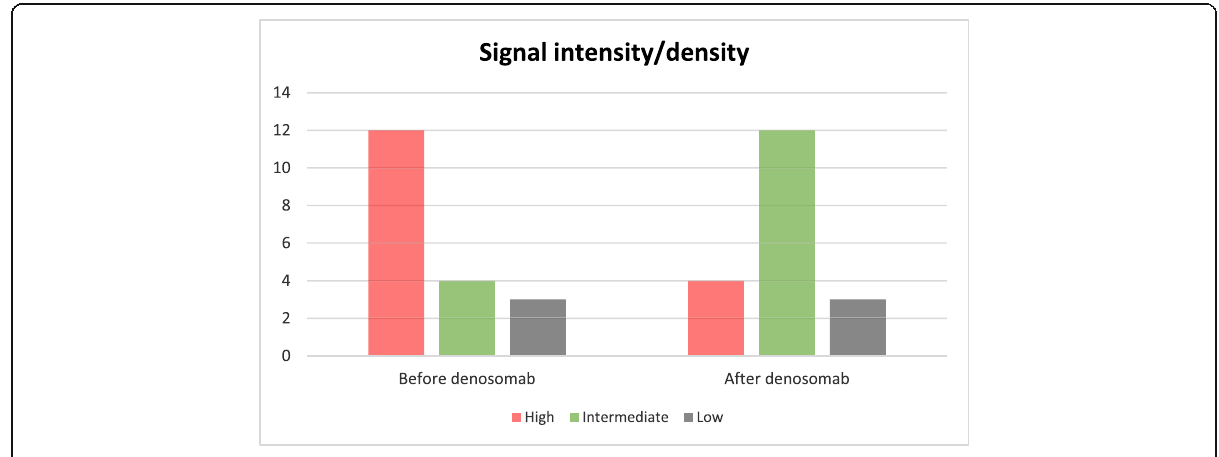
Fig. 1 Pattern of signal alteration in treated